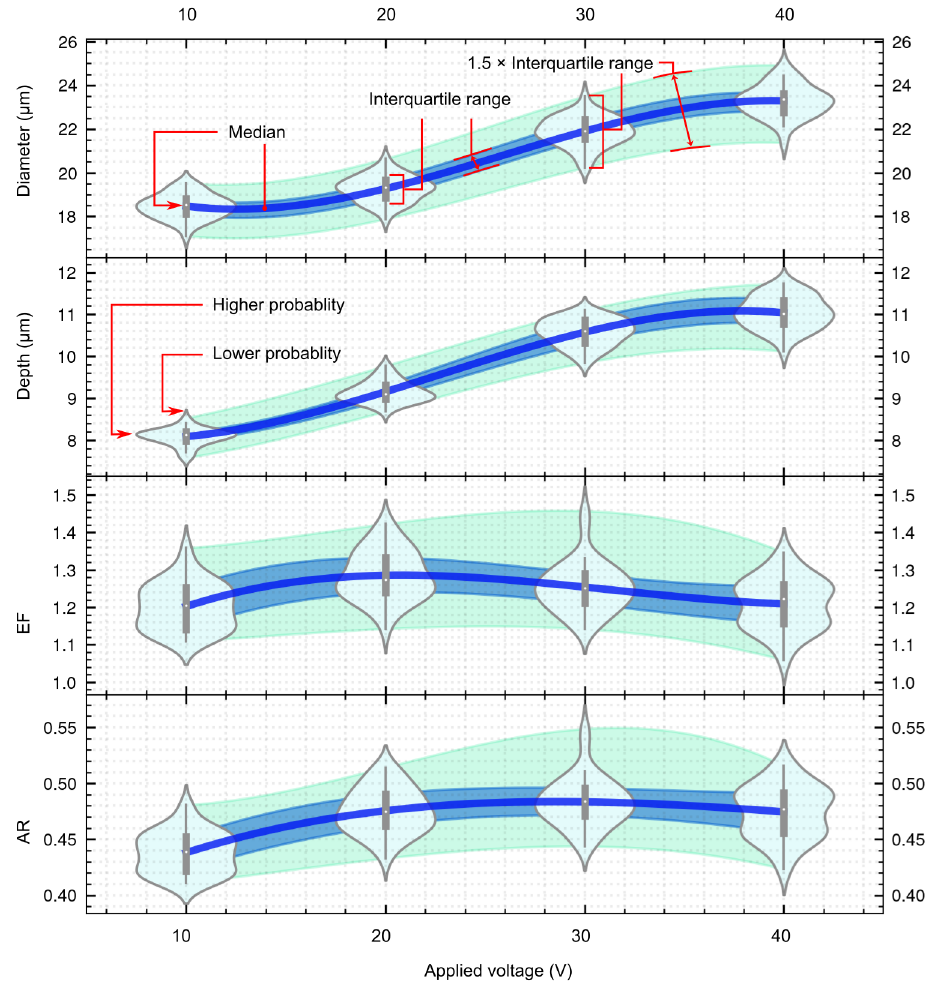
Figure A5. Explanation of violin